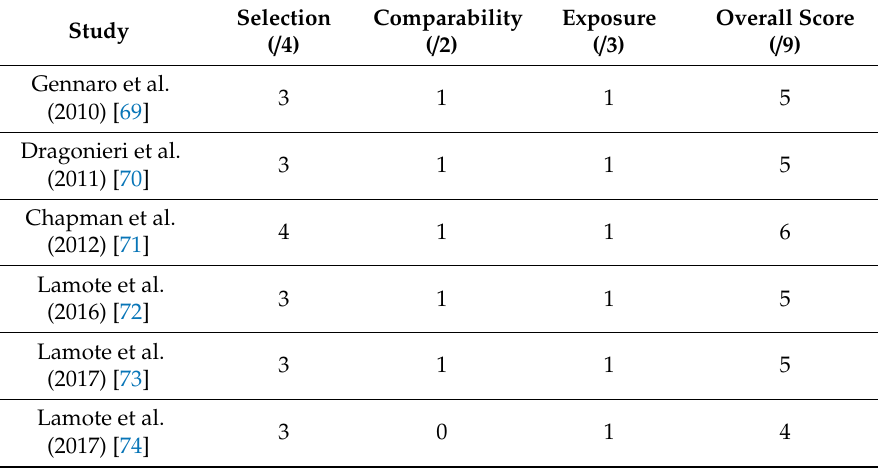
Table 2. Quality assessment of the selected